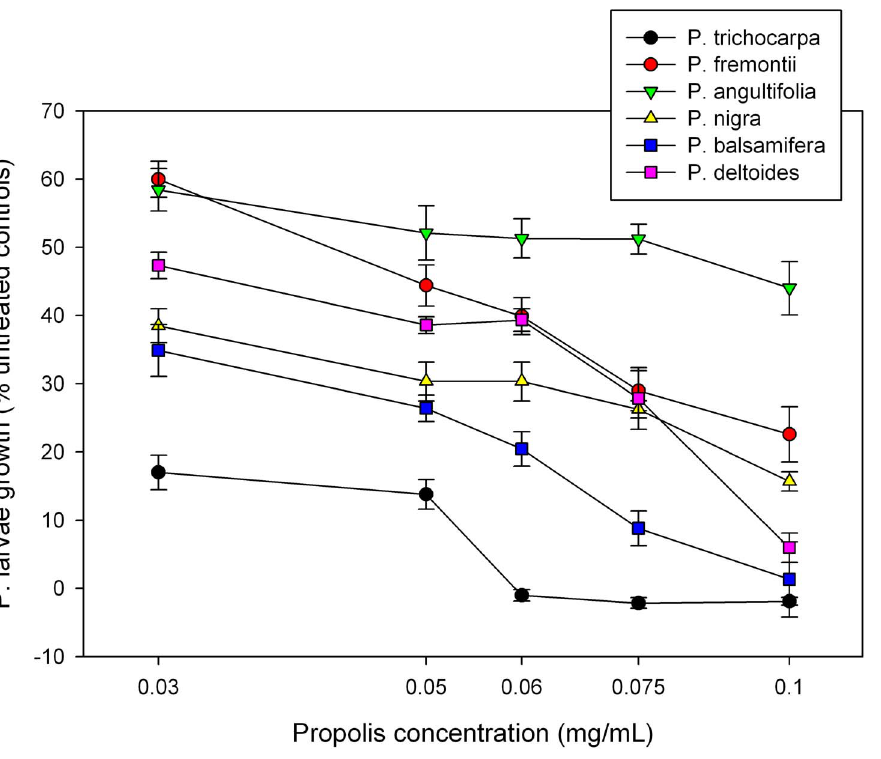
Figure 10. Inhibition of Paenibacilluslarvae by Populusspp. resin. Semi-log plot of the antimicrobial activity of resin from six representative Populus spp . individuals against P. larvae , a brood pathogen of honey bees. Antimicrobial activity was evaluated spectrophotmetrically at OD 600 relative to untreated controls. N=8 replicates per sample per concentration of resin.